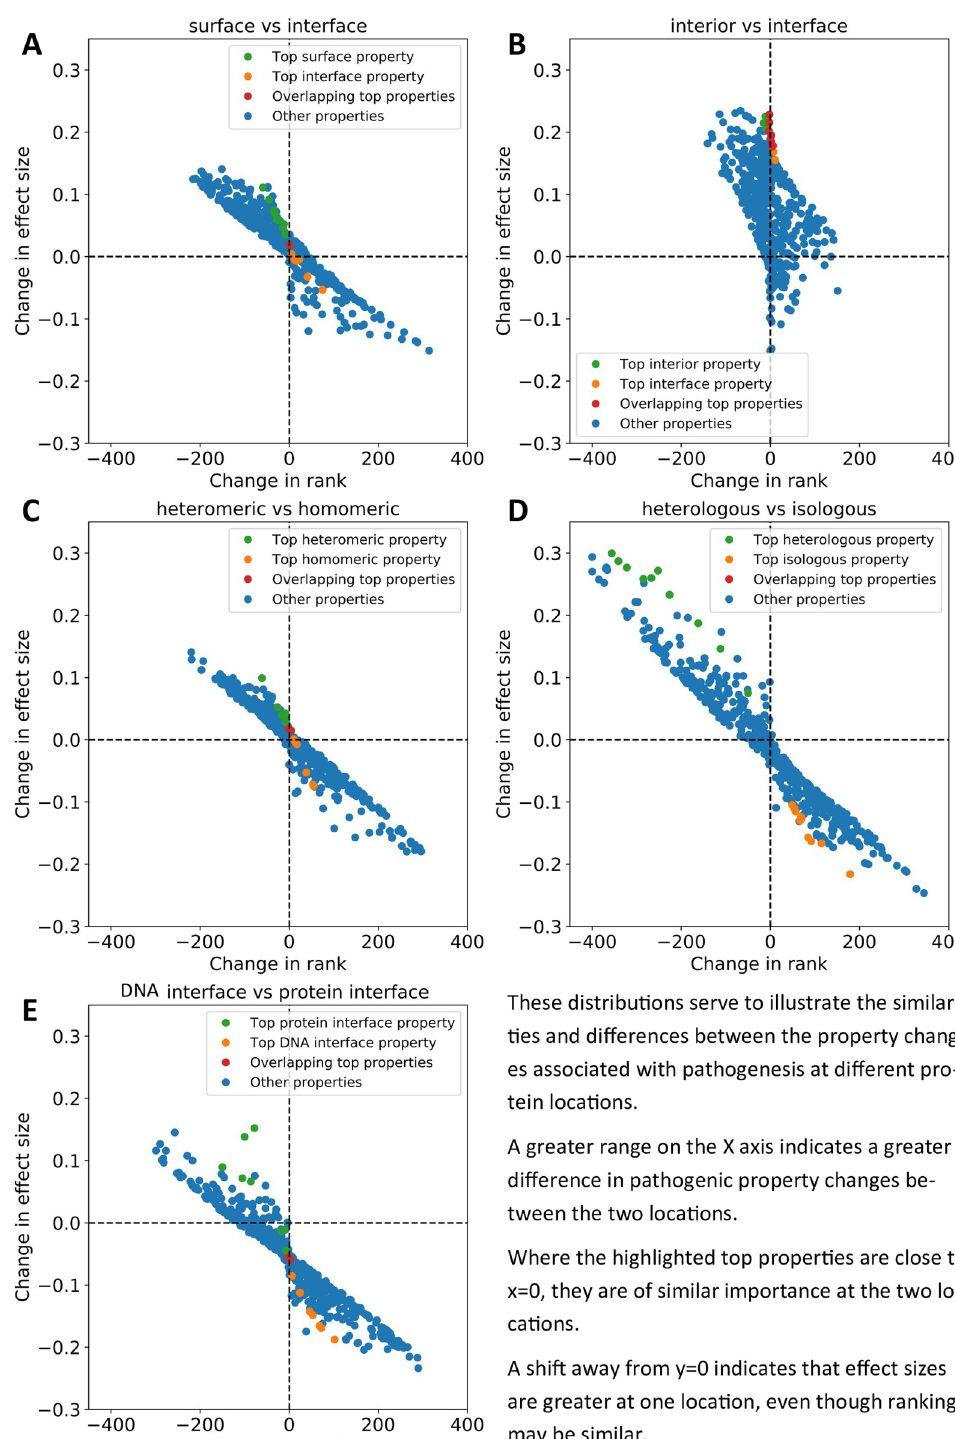
Fig 6. Differences in property changes (delta properties) between locations plotted against rank change of those properties. Effect size difference in the delta properties of two locations is on the Y-axis, and rank change of the delta properties is on the X-axis. The top properties (by effect size) for each location are coloured green and orange, while overlapping top properties are coloured red. A) Surface locations vs all interfaces. B) Interior locations vs all interfaces. C) Heteromeric vs homomeric interfaces. D) Heterologous vs isologous interfaces. E) DNA interfaces vs all protein interfaces.